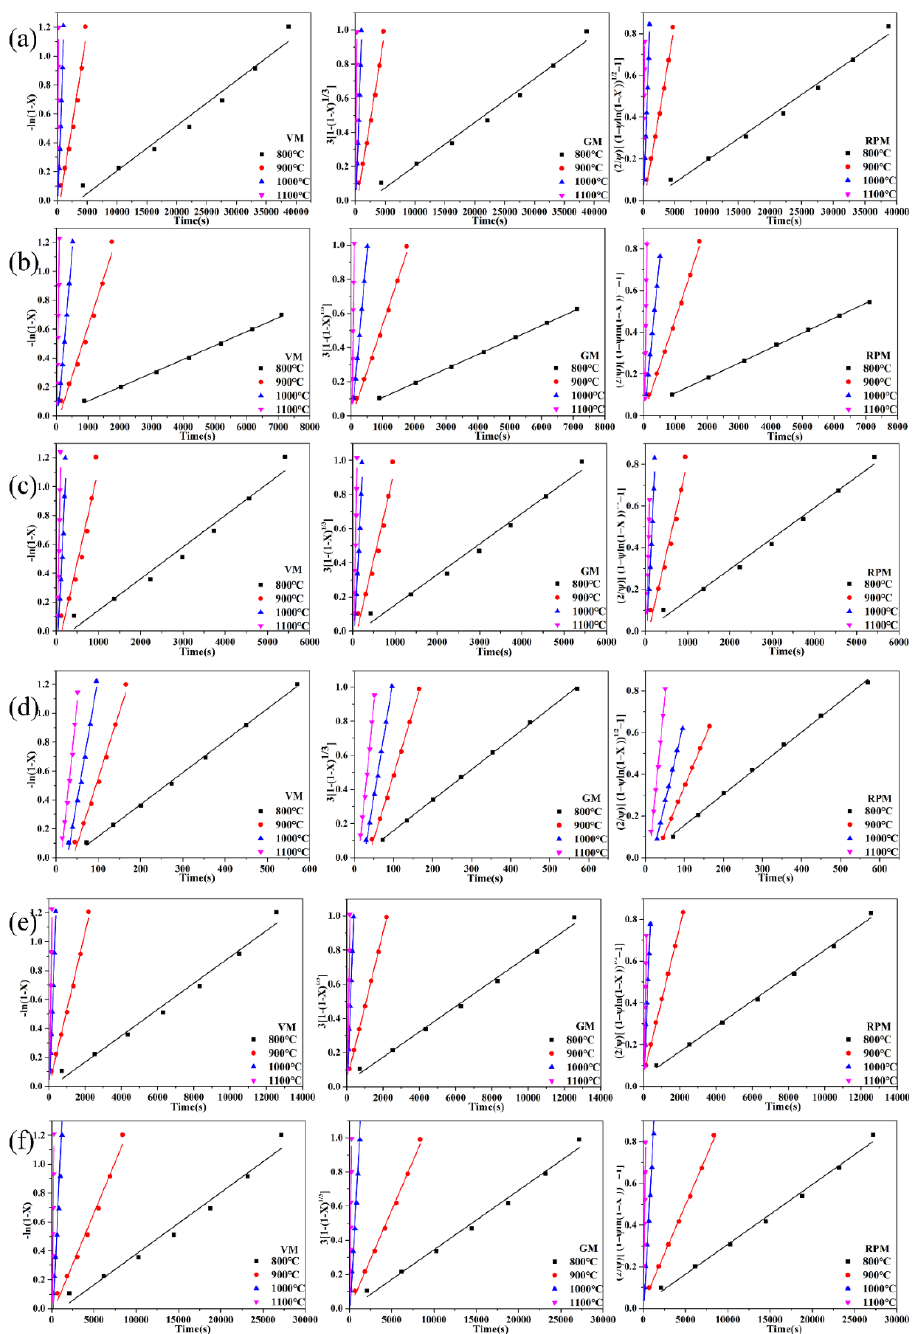
Figure 4. Plots fitting of VM, GM and RPM for ( a ) AW, ( b ) RAW, ( c ) AW-KCl, ( d ) AW-CaCl 2 , ( e ) AW-NiCl 2, ( f ) AW-ZnCl 2 .